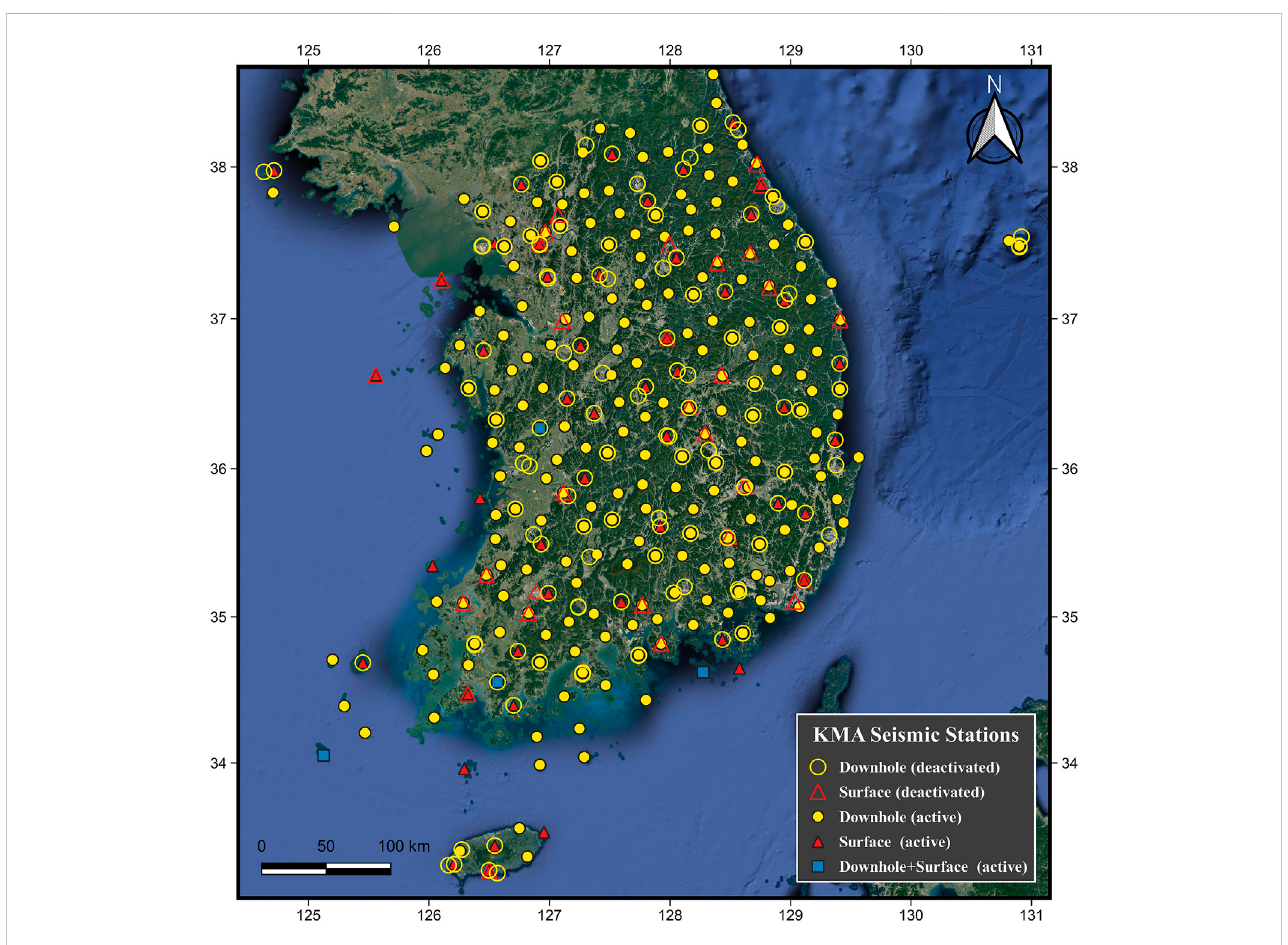
FIGURE 1 LocationofKMAseismicstations.Symbolshapesindicatetheinstallationdepthofsensorsperstation,andhollownessdistinguishestheoperationstatus.